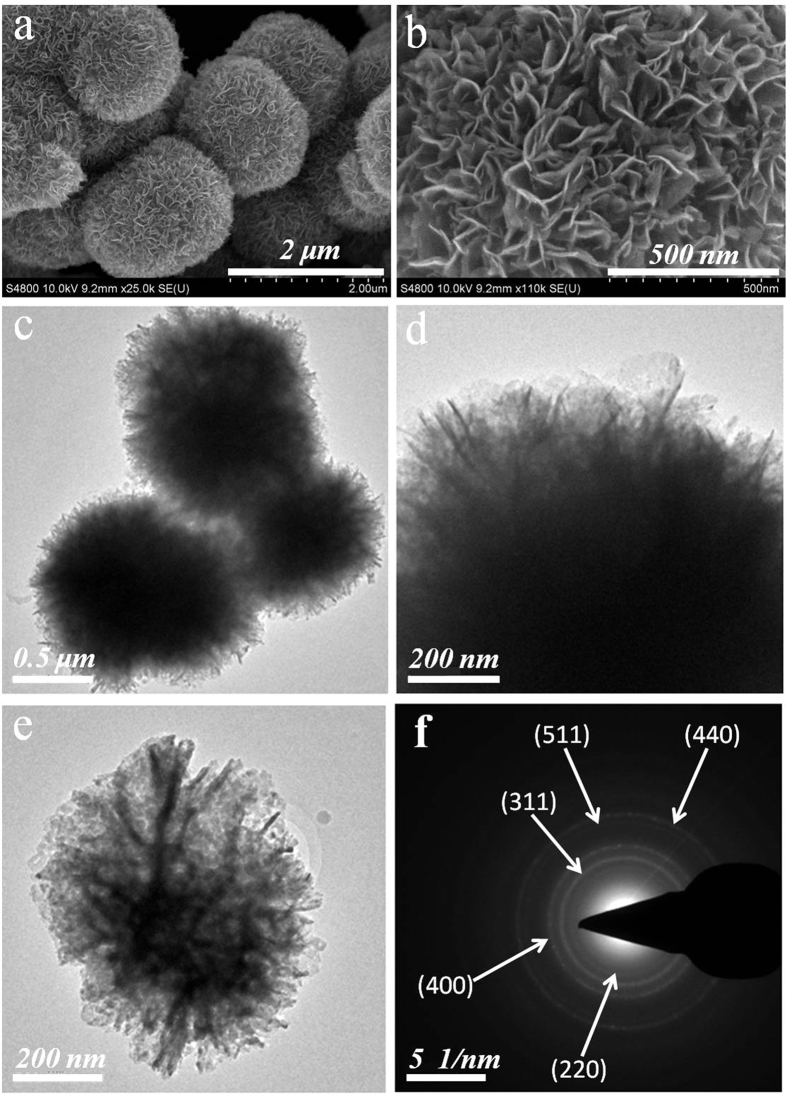
(a,b) FE-SEM, (c–e) TEM images at different magnifications, (f) SAED pattern of porous NiCo2O4 microspheres.